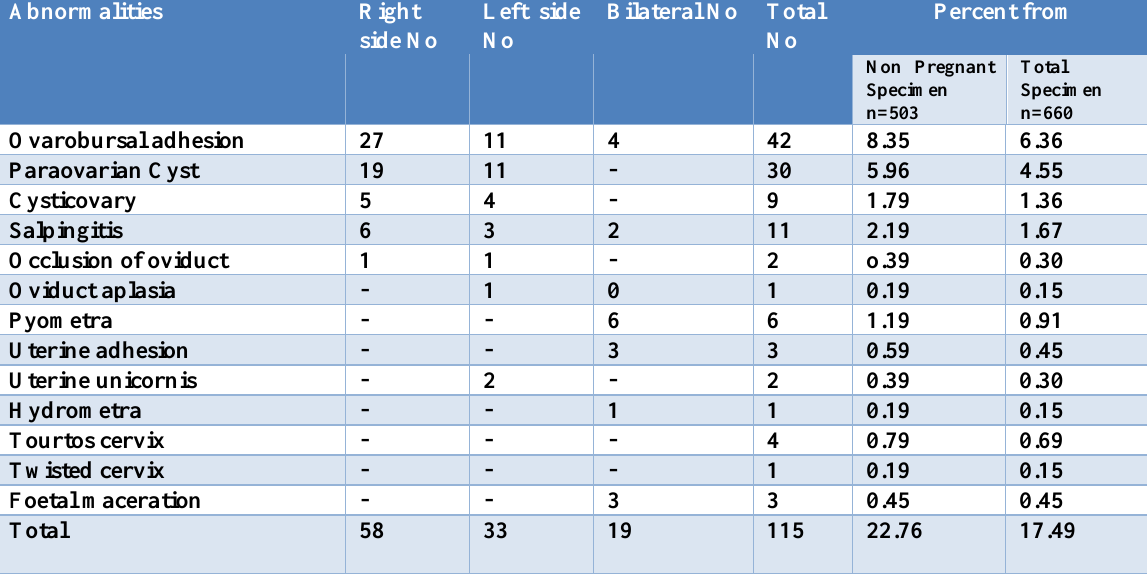
Table, 2: Gross abnormalities in non-pregnant of Iraqi ewes .